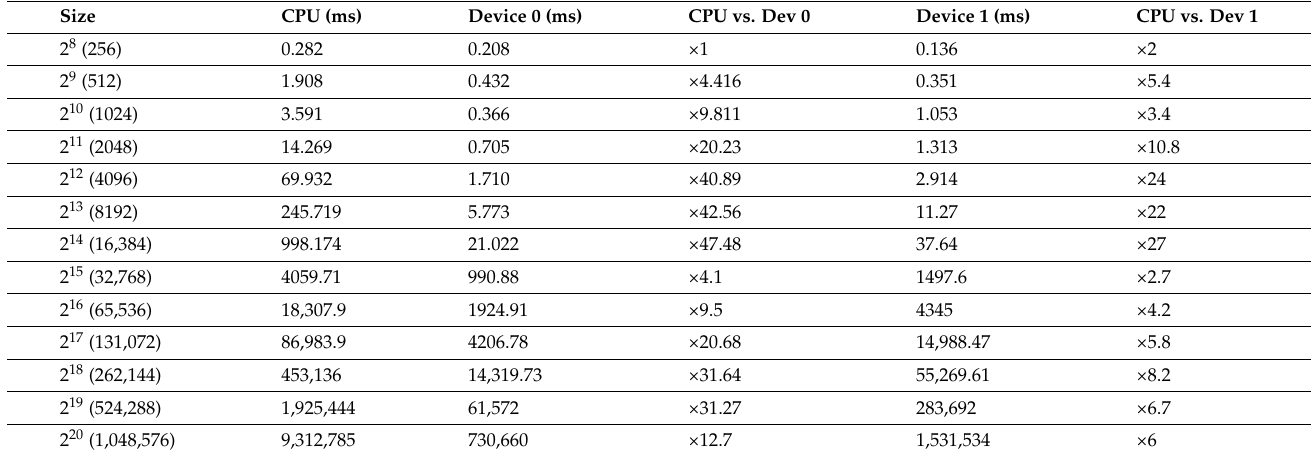
Table 4. Computing differential uniformity